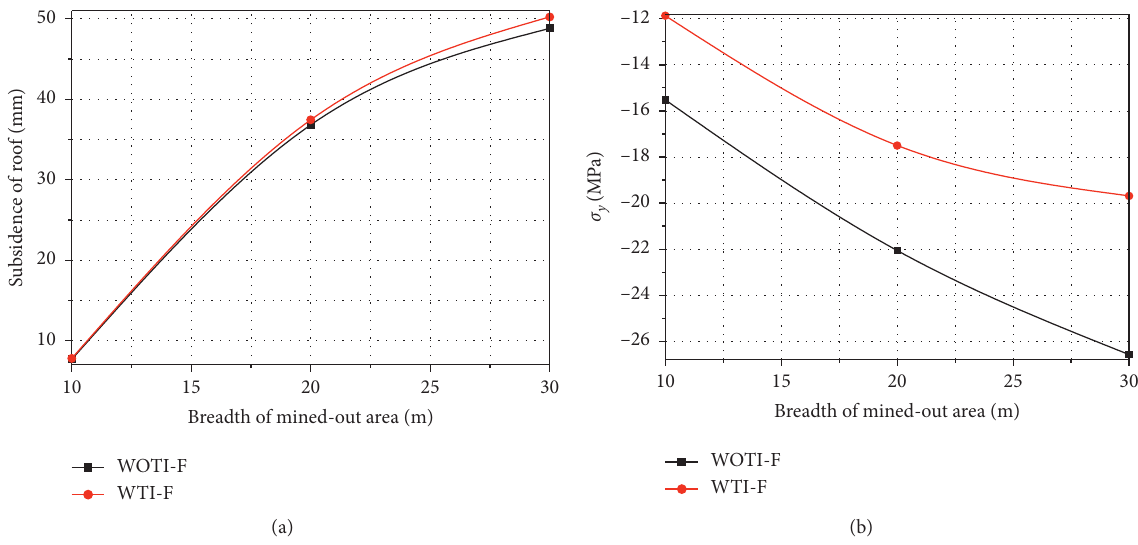
Figure 30: Analysis of calculation of reverse direction fault with initial fracture. (a) Subsidence of the roof. (b) Vertical stress.